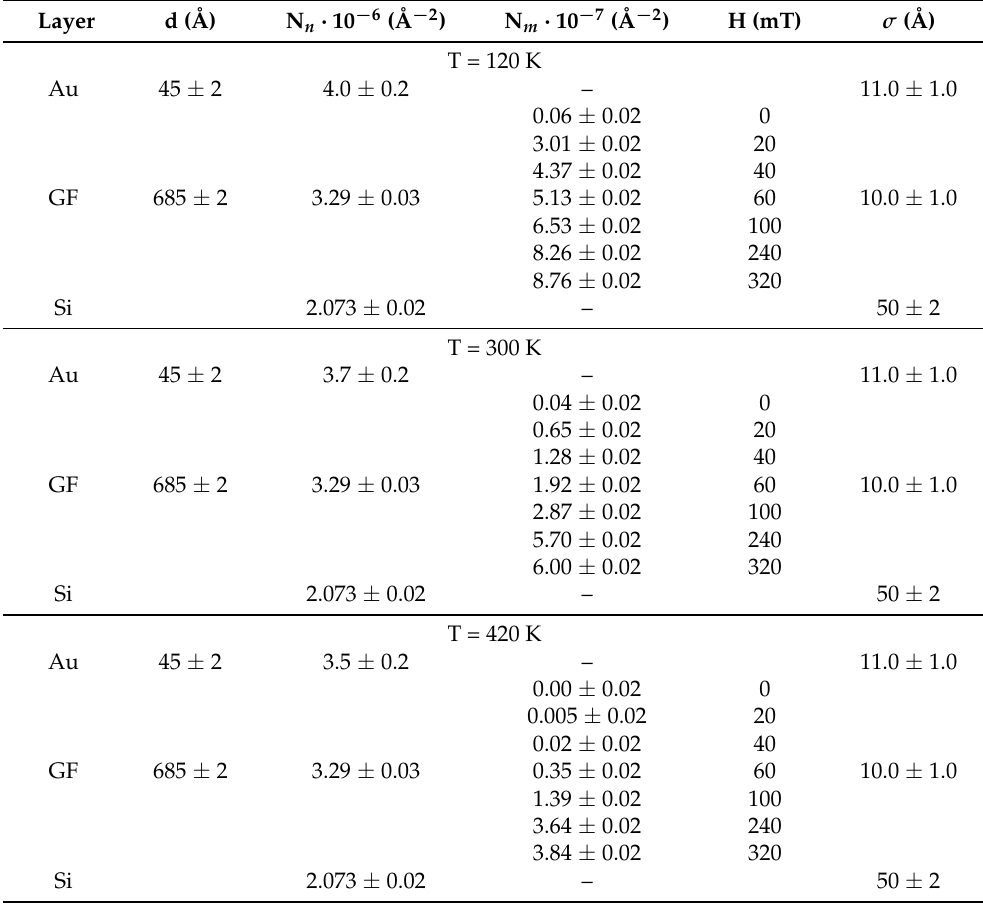
Table 3. Parameters of the model used to approximate the PNR curves for Au/SiO 2 (70 at.%